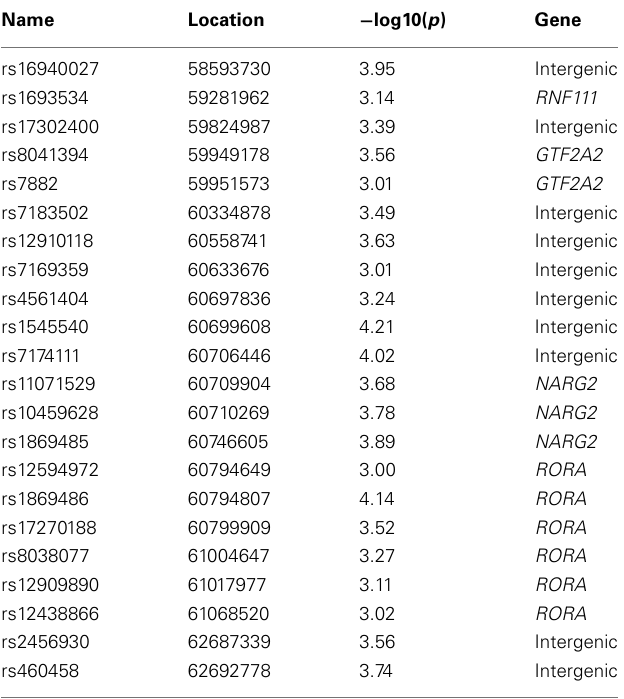
of 5.6 Mb harbors over 30 genes, many of which are critical